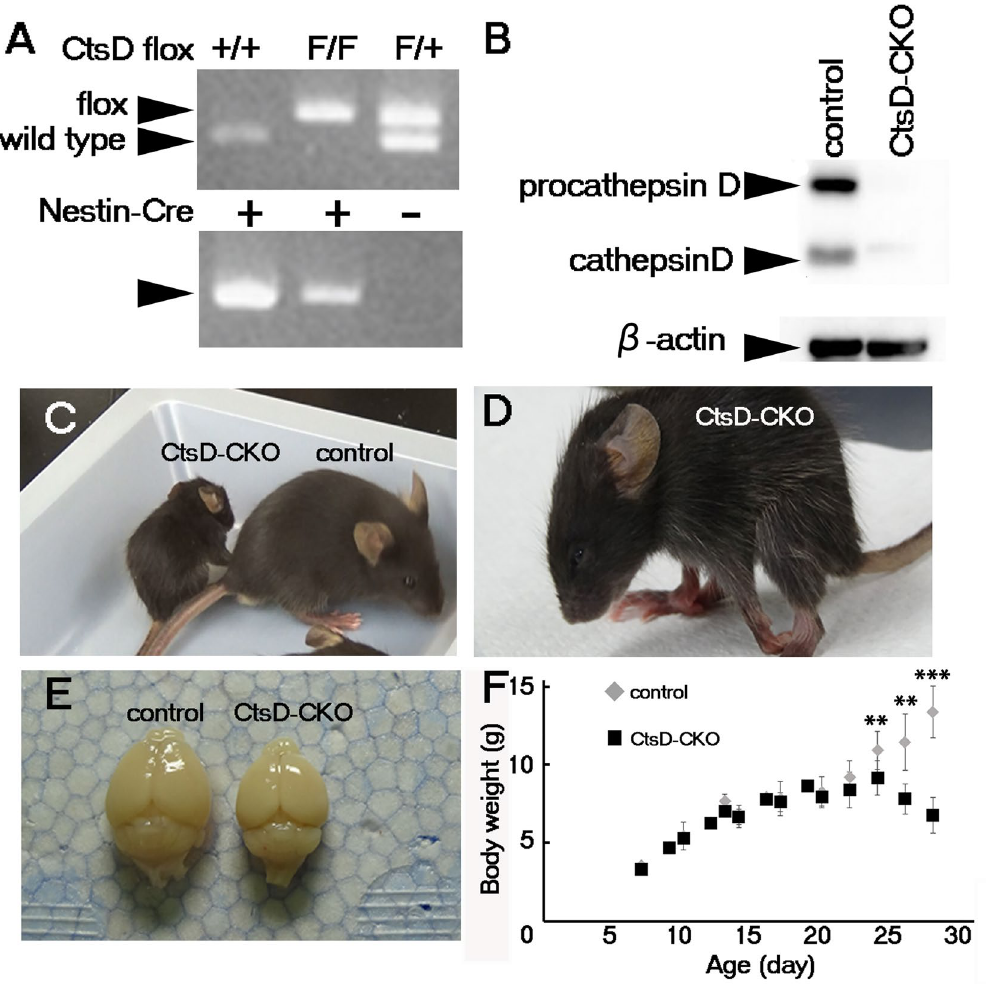
Figure 1. CtsD-Nes mice show stunted growth and neurological dysfunction. ( A ) Genotyping of CtsD-CKO (CtsD flox/flox ; Nestin-Cre) mice. “F” in the upper panel indicates CtsD-floxed alleles (about 800 bp), and “+” indicates wild type alleles (about 700 bp). In the lower panel, “+” indicates Nestin-Cre transgenes (about 900 bp). ( B ) Representative image of immunoblotting of CtsD in whole brain lysates from the CtsD-CKO and control littermate mice at p14. Molecular masses of pro-cathepsin D (about 46 kDa) and mature cathepsin D (about 28 kDa) are decreased in CtsD-CKO brain lysates. As a loading control in each well, ß-actin is detected using anti- ß-actin antibody. ( C – E ) Physiological findings of a 32-day-old CtsD-CKO mouse. The CtsD-CKO mouse is smaller in size than the control littermate mouse ( C ), and shows a kinetic epilepsy-like phenotype ( D ). The size of the brain of CtsD-CKO mouse was smaller than that of the control littermate mouse ( E ). ( F ) Growth defect of CtsD-CKO mice (**p < 0.03, ***p < 0.001, n = three to eleven mice from each genotype mouse.). "Control" indicates CtsD flox/flox mouse, and “CtsD-CKO” indicates CtsD flox/flox ; Nestin-Cre mouse. Supplementary Fig. 7 shows uncropped PCR banding patterns and